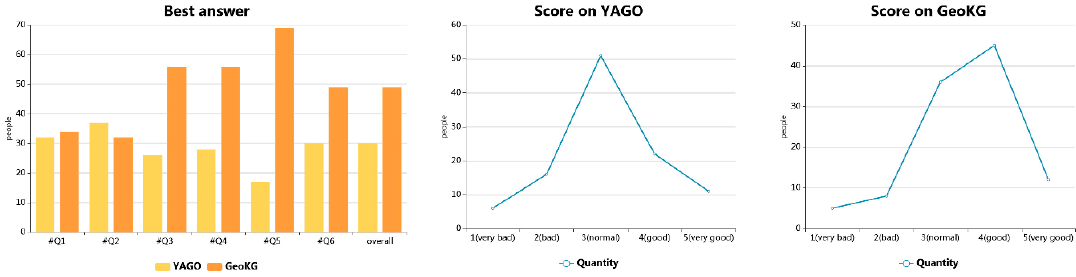
Figure 10. The best answer on #Q1–#Q6 and the overall scores of the YAGO and the GeoKG.